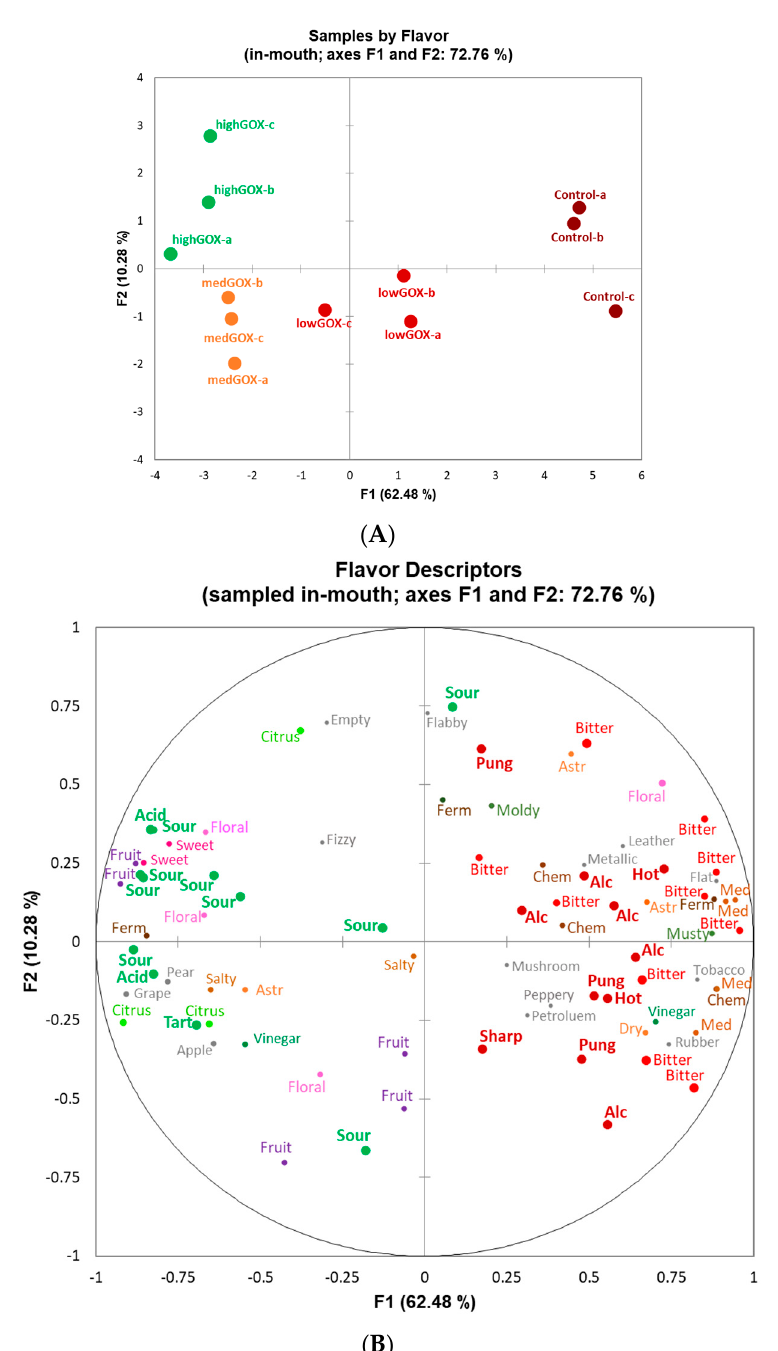
Figure 4. Plots of ( A ) sample consensus space by ( B ) flavor (sampled in-mouth) attributes ( A ). Sample consensus space of untreated (control) samples and GOX-treated samples by level (lowGOX, medGOX, highGOX) and evaluation replicate (a, b, c) resulting from ( B ) flavor characterization by panelists using flash profile via generalized procrustes analysis. Similar colors of attribute words indicate similar flavor notes. Acid = Acidic, Alc = Alcoholic, Chem = Chemical, Ferm = Fermented, Med = Medicinal, Pung = Pungent.